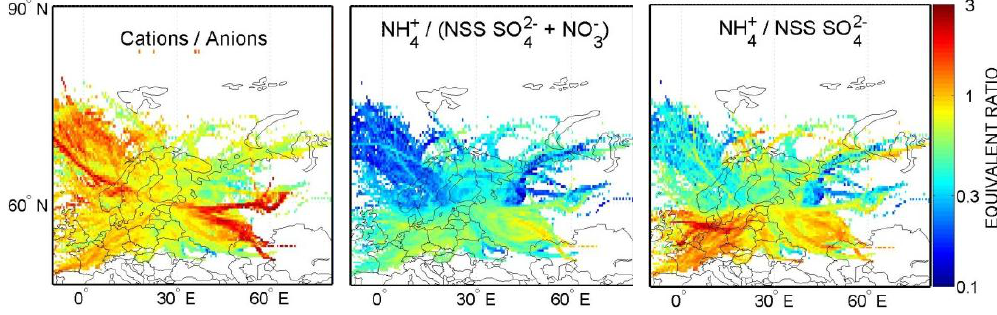
Fig. 15. Trajectory statistics of the ion equivalent ratios presented in Fig.